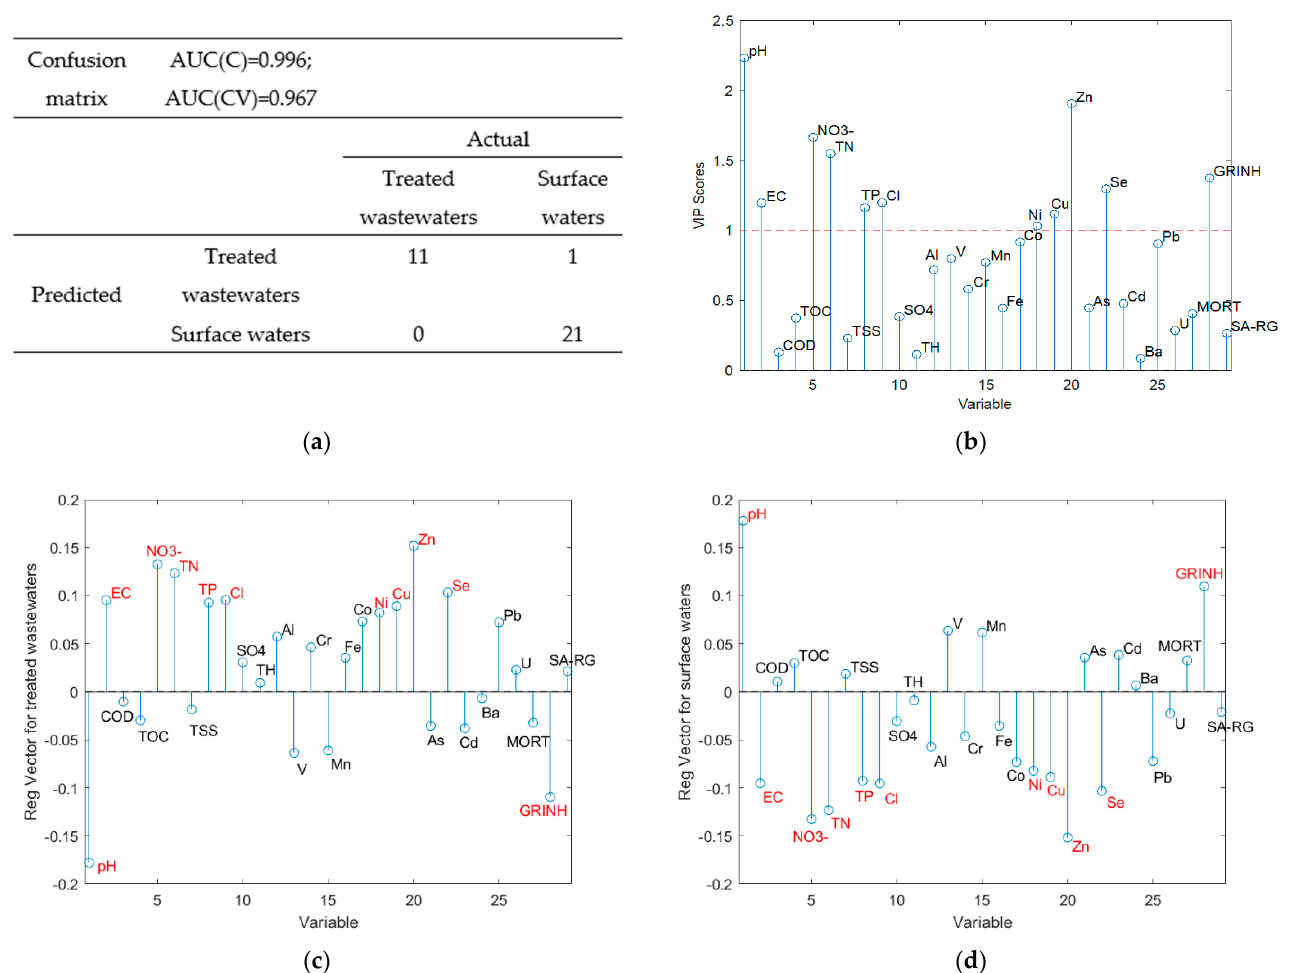
Figure 7. The partial least squares–discriminant analysis (PLS-DA) model results for treated wastewaters and surface waters based on physicochemical parameters and ecotoxicological endpoints: ( a ) Confusion matrix; ( b ) VIP (variable importance on projection) scores; ( c ) Regression vector for treated wastewaters (variables with significant contribution are marked in red); ( d ) Regression vector for surface waters (variables with significant contribution are marked in red).